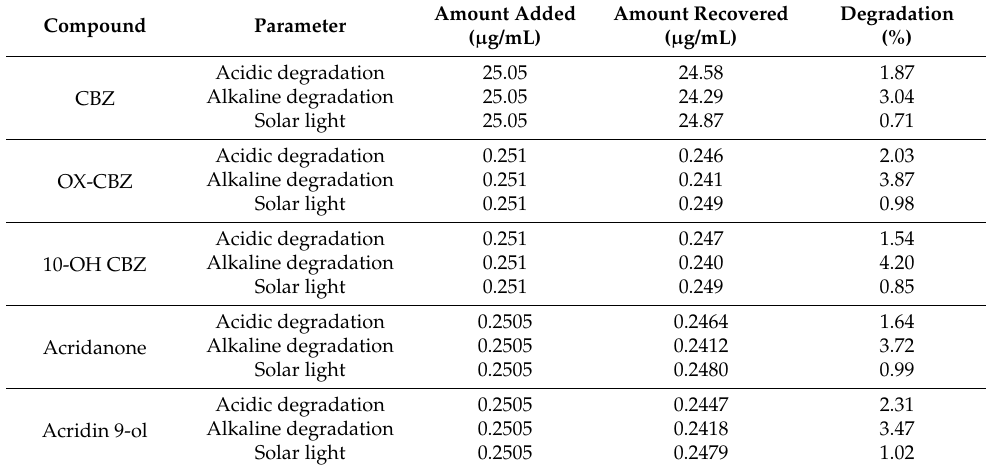
Table 5. Specificity values of CBZ and the detected degradation intermediates in water.